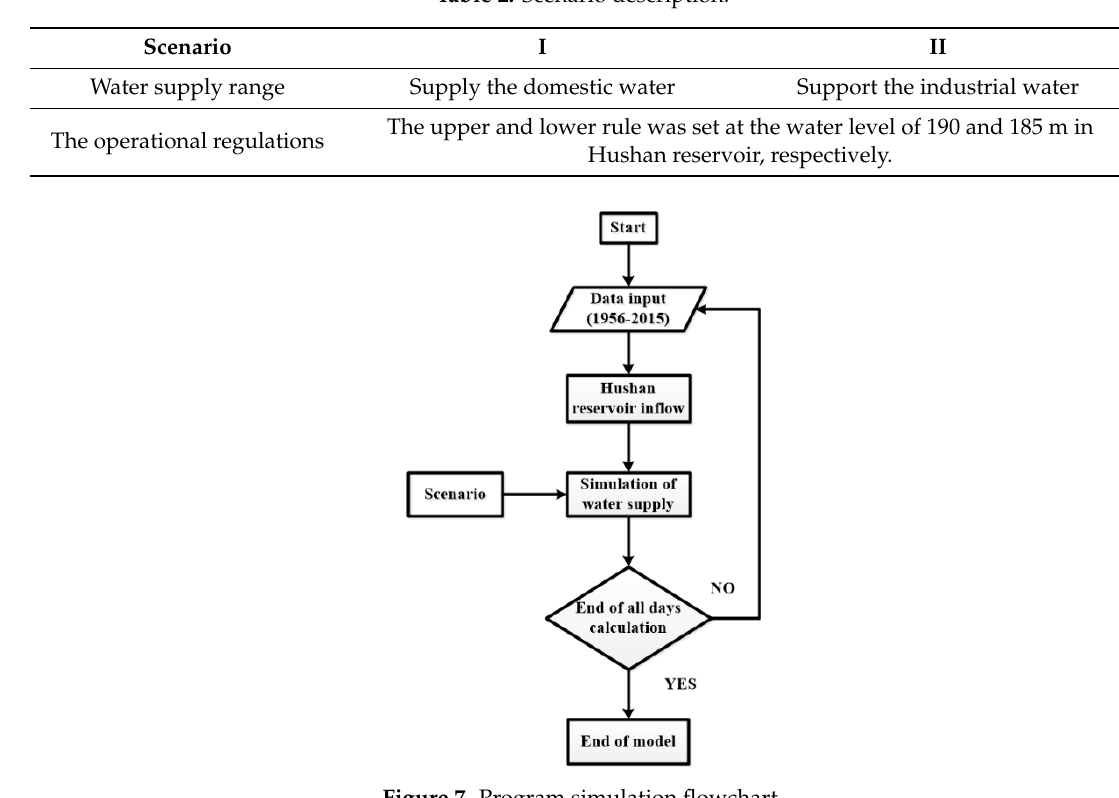
Figure 7. Program simulation flowchart.